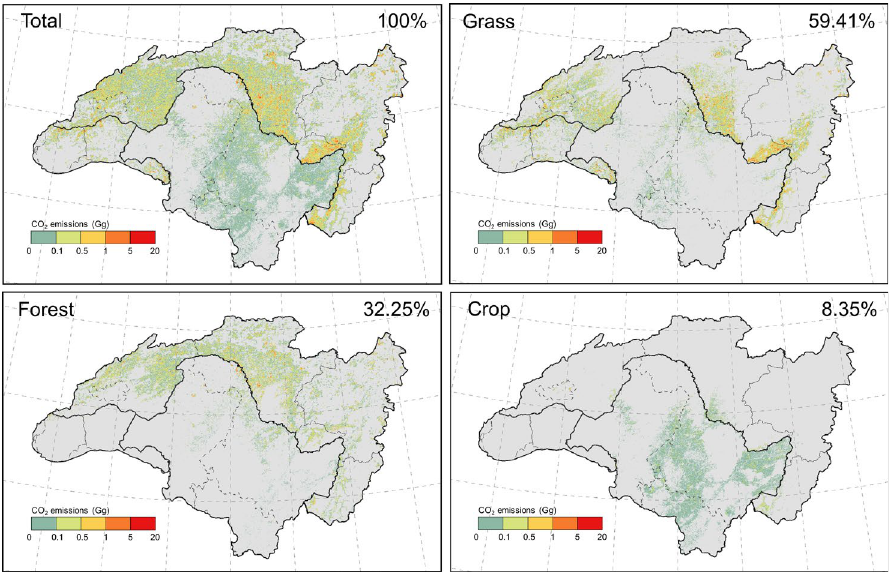
Figure 2. The average annual CO 2 emissions from biomass burning in the Amur River Basin for 2003–2020 (unit: Gg).